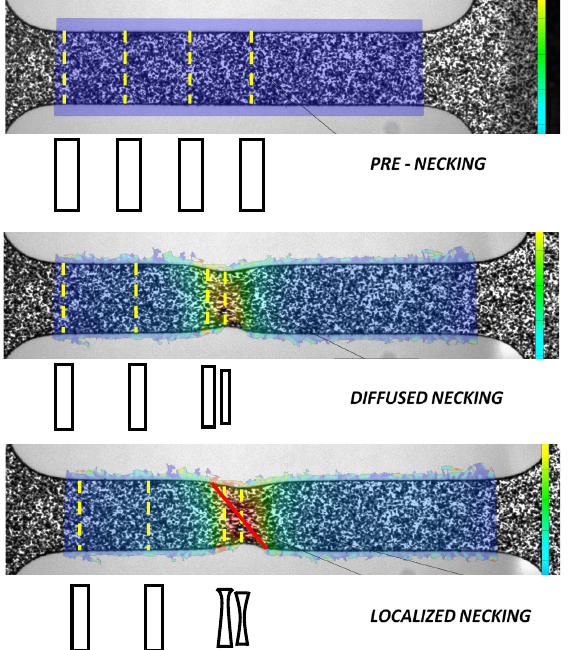
Figure 5. Cross-sections of a flat tensile specimen before necking, after diffused necking, and after localized necking.